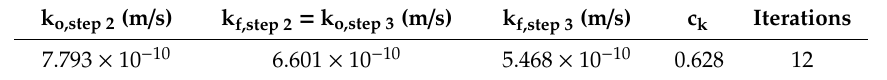
Table 10. Third application. c k and initial and final hydraulic conductivities for loading steps 2 and 3.